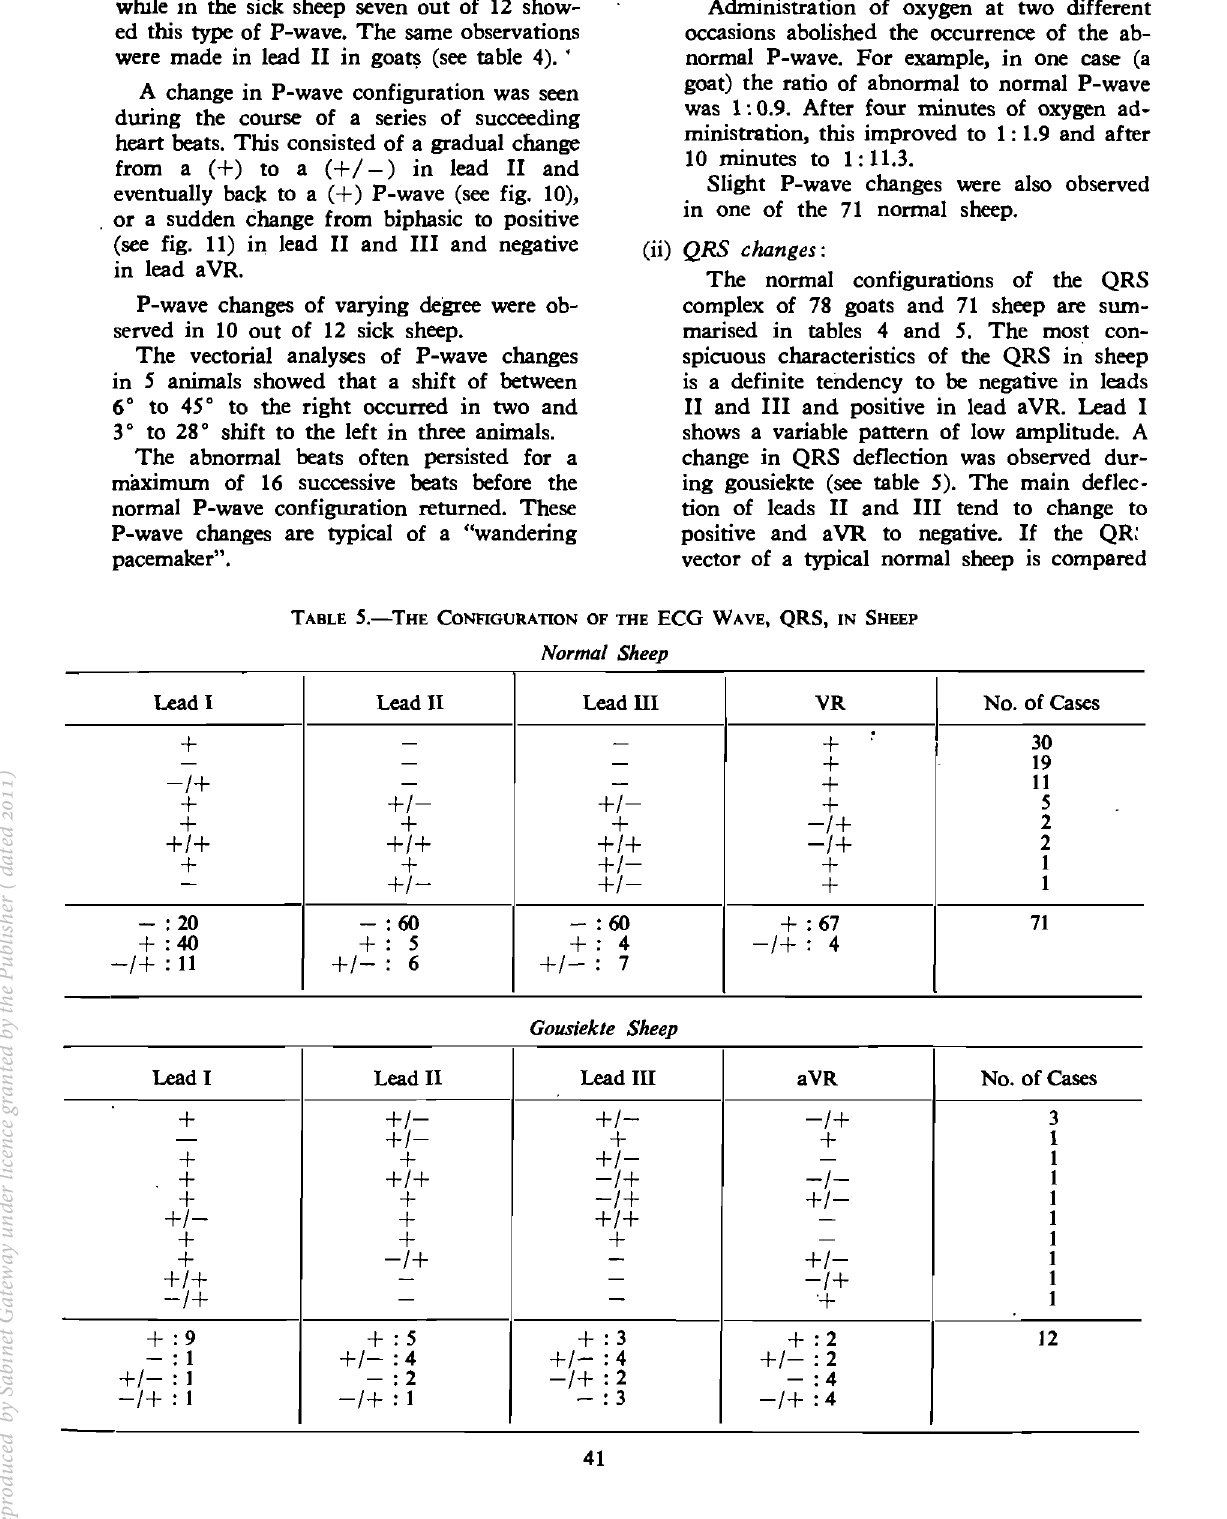
TABLE 5.-THE CONFIGURATION OF THE ECG WAVE, QRS, IN SHEEP Normal